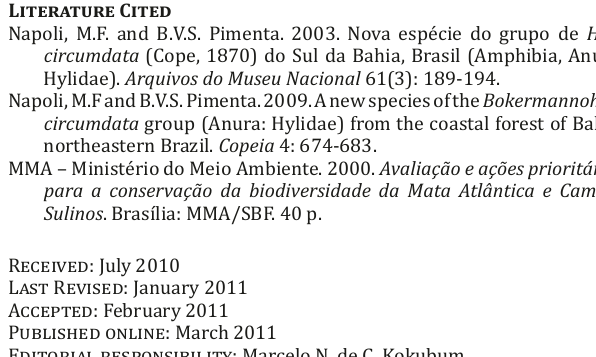
Bokermannohyla lucianae in Brazil. The major rivers of southern Bahia are numbered as follows: 1, Contas river; 2, Cachoeira river; 3, Pardo river; 4, Jequitinhonha river. BA, state of Bahia; MG, state of Minas Gerais; ES, state of Espírito Santo. Conservation priority: Extremely High (dashed red) and Very High (dashed black) (MMA